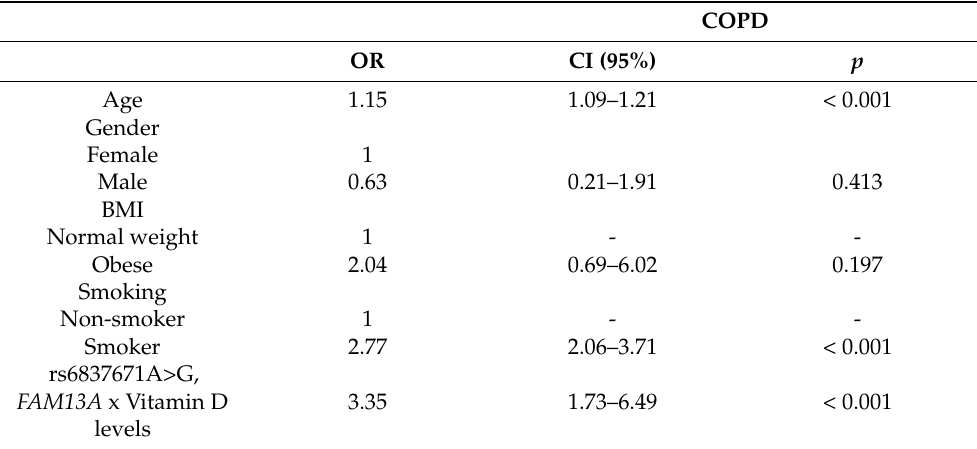
Table 3. Interaction analysis with chronic obstructive pulmonary disease.